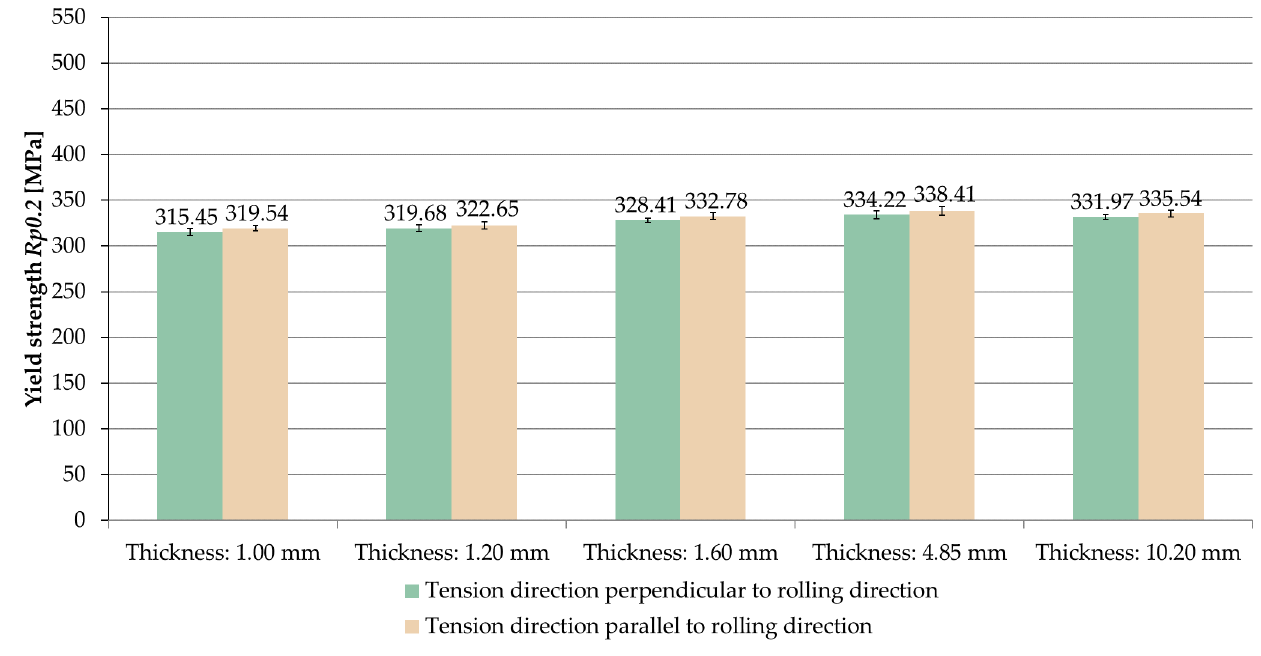
Figure 11. Yield strength R p 0.2 depending on the thickness of the sample and the ratio of the tension direction to the rolling direction. The same relationship was found as in the case of ultimate tensile strength UTS R m . On the basis of the results, it was noticed that for the samples stretched parallel to